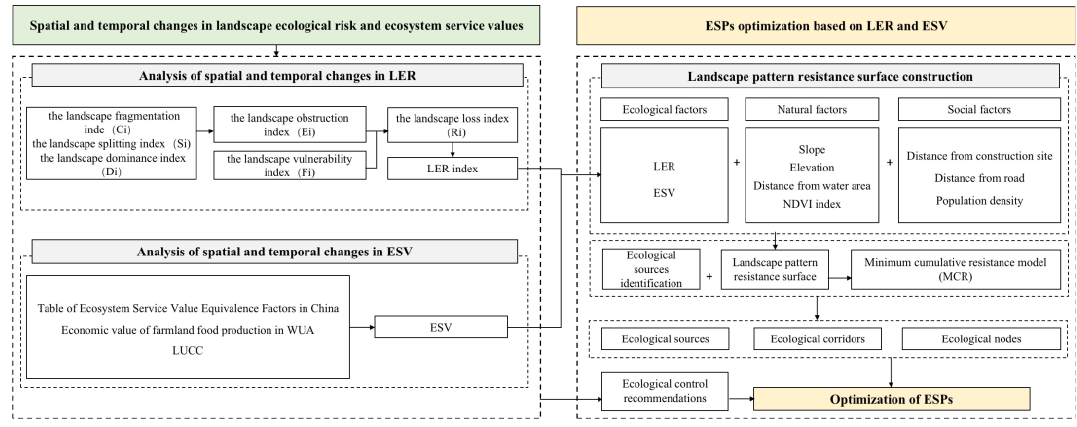
Figure 2. Research ideas and